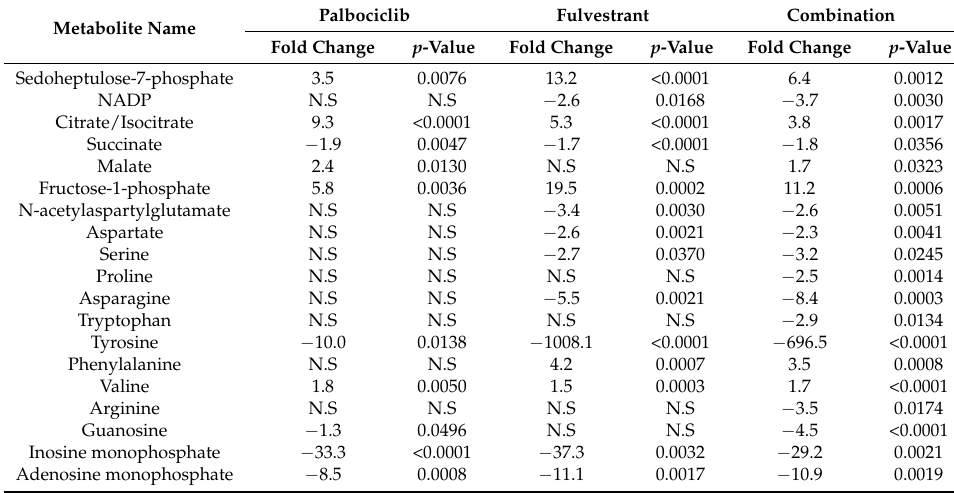
Table 2. Panel of significantly altered metabolites 7 days after dosing with palbociclib ( n = 4), fulvestrant ( n = 4), or a combination dose of both palbociclib and fulvestrant ( n = 4) when comparing dosed groups to control. Values are log transformed fold changes after quantification by multiple reaction monitoring, unpaired two-tailed t